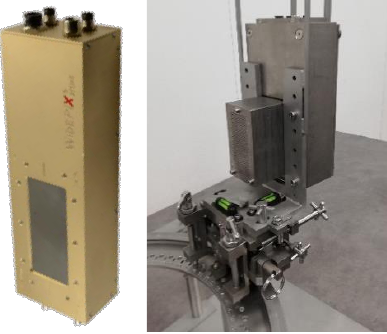
Fig. 3. 2D gamma imaging camera. Left: Advacam WidePix sensor. Right: sensor housed in the collimation box and mounted on its alignment support.